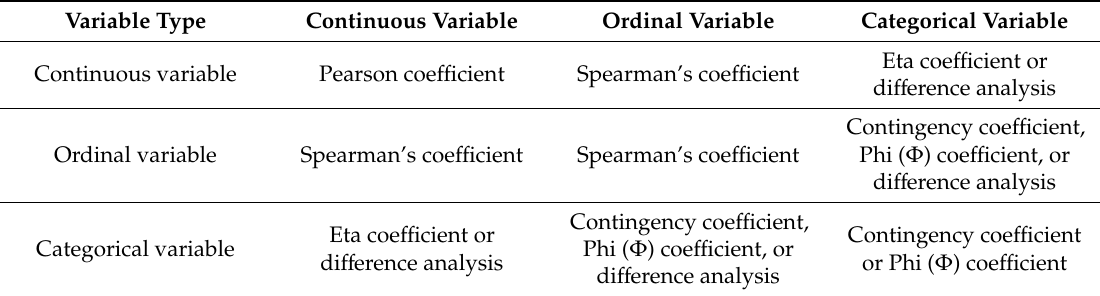
Table 5. Methods of correlation analysis for different variable types 1 .